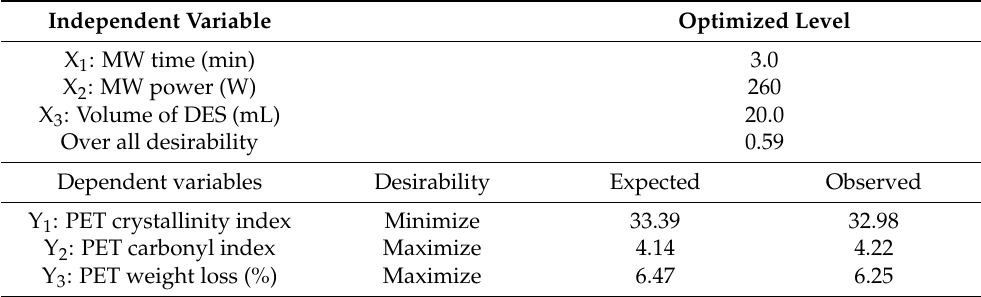
Table 4. The optimized PET pretreatment process with observed and predicted response